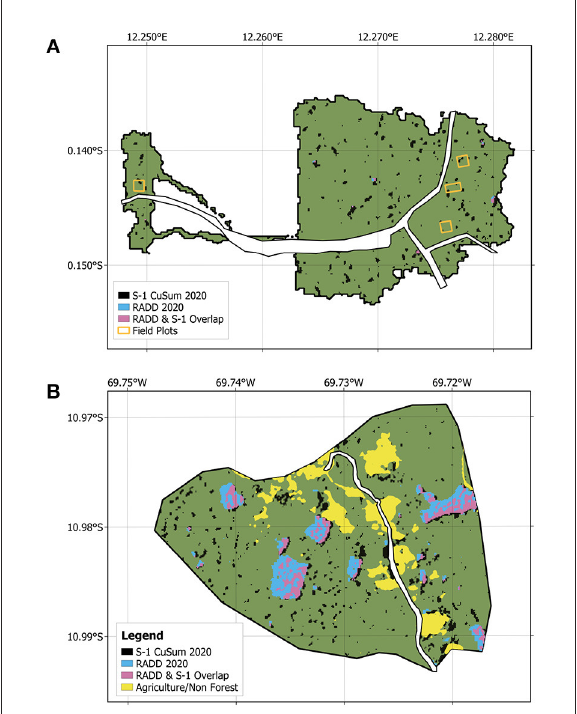
FIGURE11 Comparison between RADD Alerts (blue) (Reiche et al., 2021) and CuSum change detection algorithm (black) for disturbances in the year 2020 in our study areas in (A) Gabon and (B) Peru. Overlapping areas between the two products are color coded in pink. The non-forest mask in (B) is the product of a land cover classification produced by the authors using PlanetScope 3m resolution imagery from 16th July